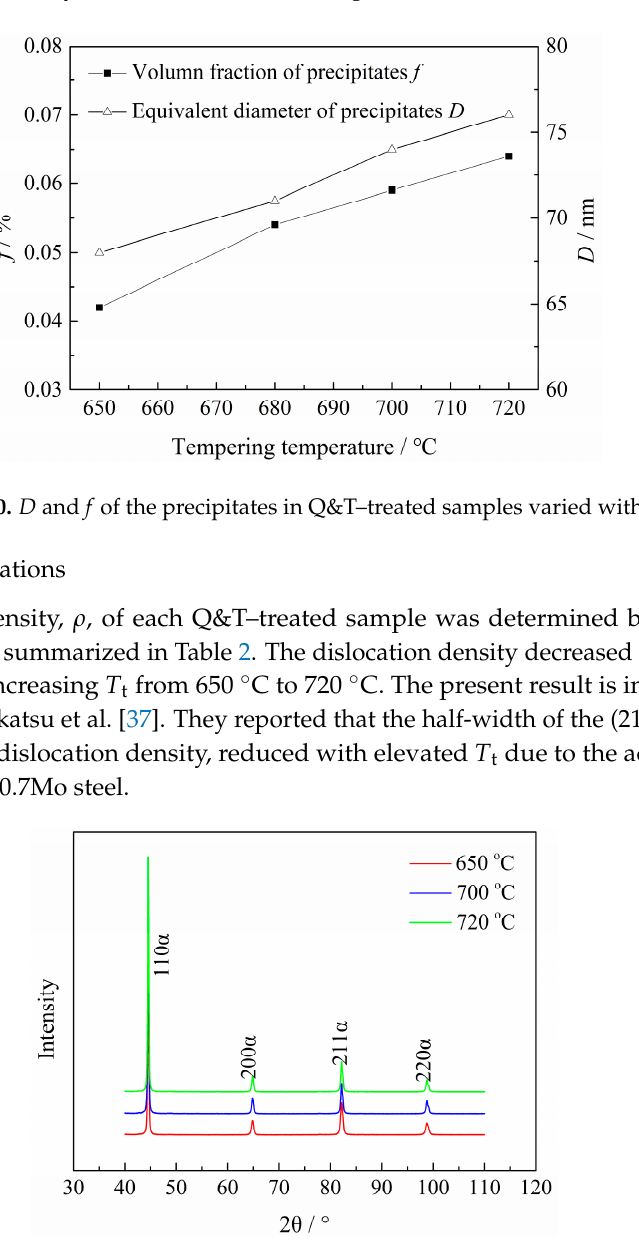
Figure 9. Typical TEM observations of martensite lath and precipitate in Q&T–treated samples at differing T t of ( a ) 650; ( b ) 700; and ( c ) 720 °C and their enlarged micrographs ( ai , bi and ci ). The red frame showing the rod-like precipitated particles distributed in the martensitic laths boundaries.